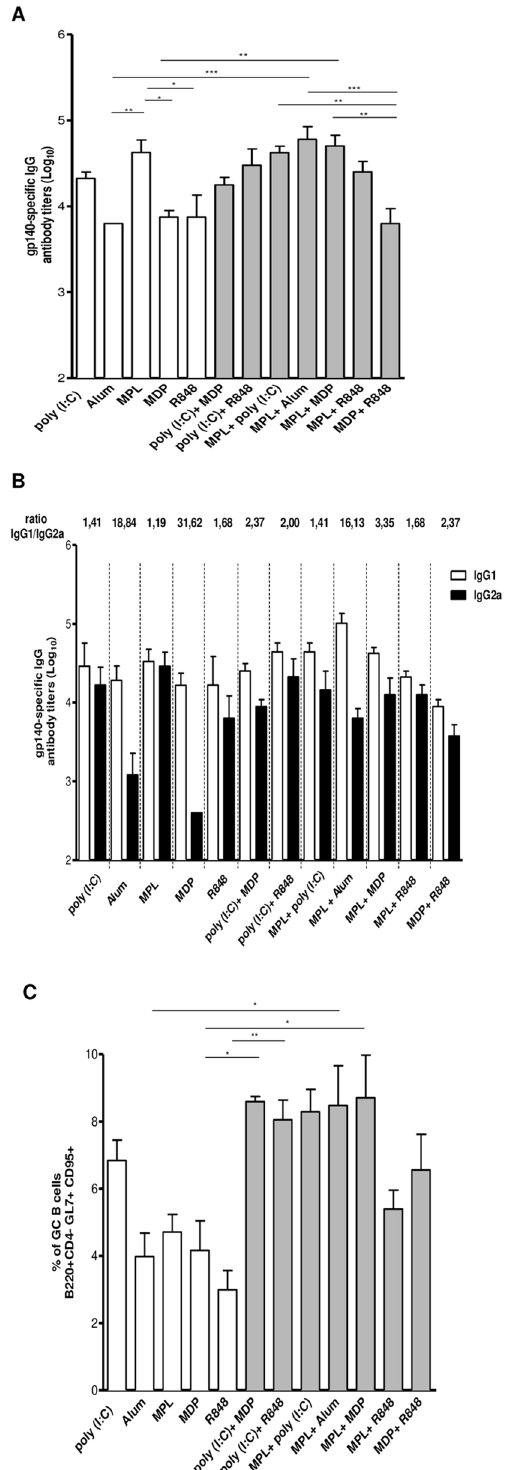
Fig 4. Combination of adjuvants exerts an additive effect on the immunogenicity of Env HIV-1 gp140 trimer. BALB/c mice (n = 5 per group) received 2 doses with 10 μ g of gp140 via s.c formulated with adjuvants individually or in combination. Fifteen days after last dose, serum was collected and analyzed by ELISA. (A) Total gp140-specific IgG antibody titers on a logarithmic scale; (B) Specific IgG subtypes; (C) Fifteen